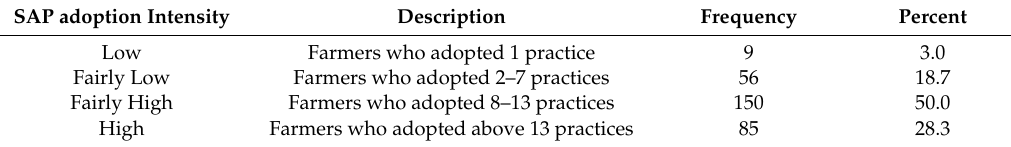
Table 5. Classification of banana farmers based on the number of SAPs